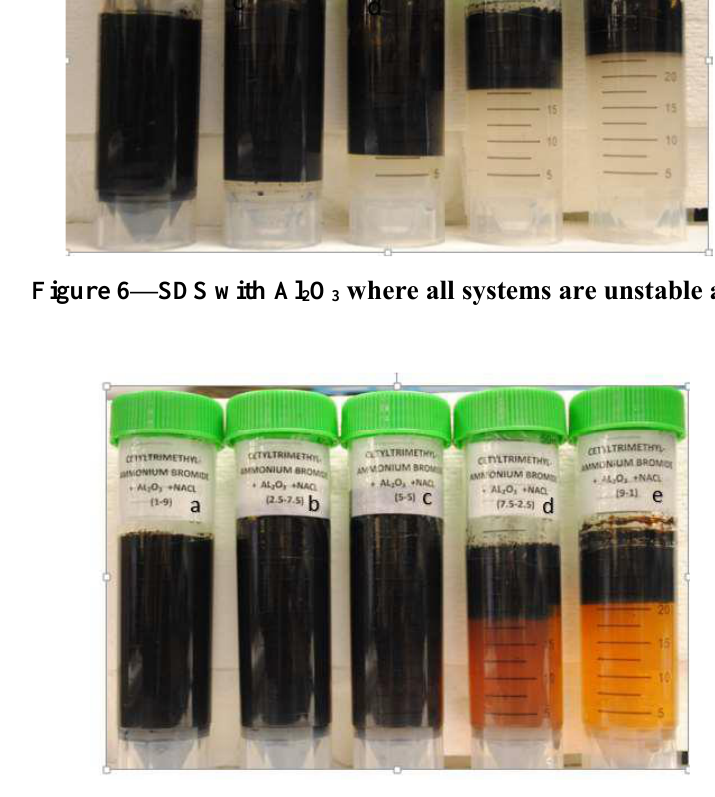
O , all unstable at 25℃. 2 3